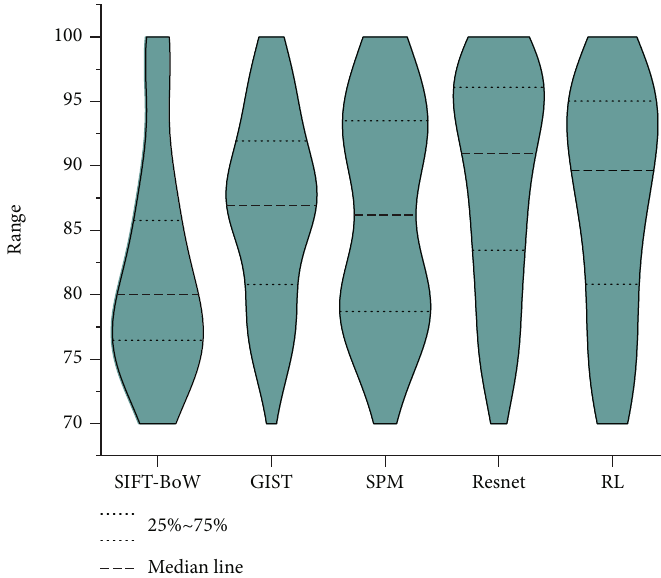
Figure 6: E ff ect of target characteristics on model detection performance and